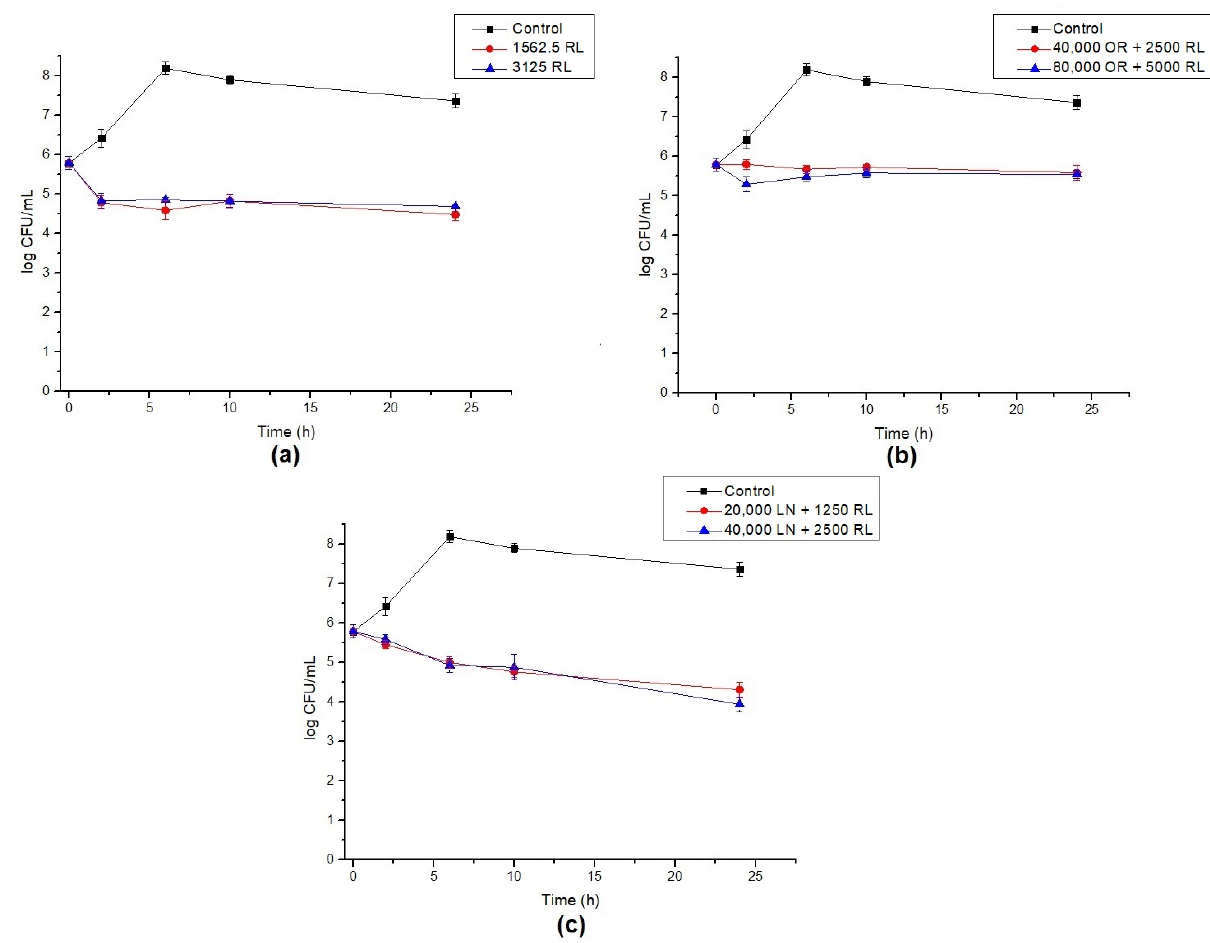
Figure 4. Log reduction in endospore germination after treatment with ( a ) RL, ( b ) OR + RL, and ( c ) LN + RL. Lines show the log CFU/mL for the control (black), 16 × MIC (red), and 32 × MIC (blue). Error bars show the standard deviation of at least three independent replicates.